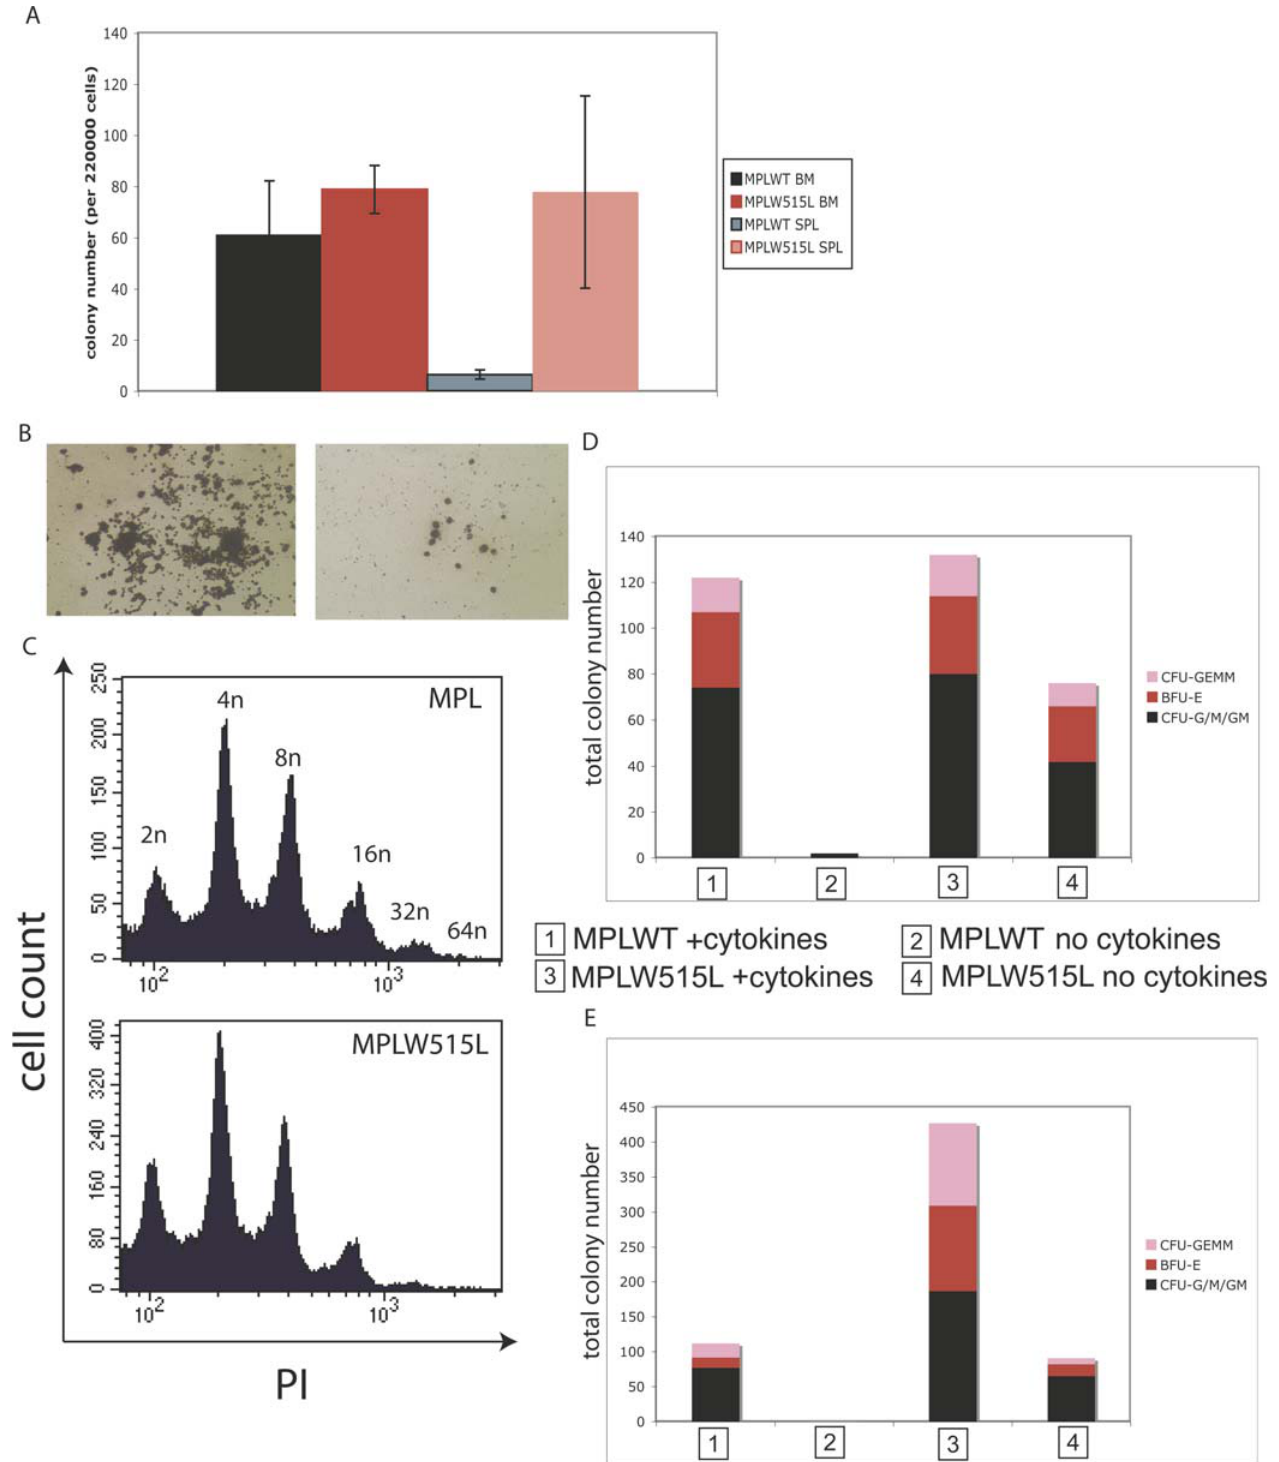
Figure 6. MPLW515L Increases the Number of Megakaryocyte and Myeloid Colonies in Spleen, without Affecting Megakaryocyte Ploidy, and Causes Cytokine-Independent Myeloid Colony Growth (A) Megakaryocyte colony–forming assay in the presence of TPO, IL3, IL11, and IL6 demonstrates similar numbers of megakaryocyte colonies obtained from MPLW515L-expressing bone marrow and an increase in the number of megakaryocyte colonies from spleen cells compared with MPLWT. (B) Acetylcholinesterase staining of megakaryocyte colonies derived from bone marrow demonstrates much larger colony size in MPLW515L as compared with MPLWT megakaryocyte colonies. (C) Megakaryocyte ploidy analysis shows the same distribution for MPLW515L-expressing cells and MPLWT-expressing cells. (D and E) Total myeloid colony formation from bone marrow cells (D) and spleen cells (E) demonstrates cytokine-independent colony formation in MPLW515L bone marrow and spleen. There is no difference in colony distribution between MPLWT- and MPLW515L-expressing cells. Colony counts reflect only positively identifiable colonies, with thorough megakaryocyte colony analysis done in MegaCult assay (Figure 6A), and thus are excluded from methylcellulose colony analysis. Colony numbers represent a total of three representative mice per group, in duplicate. DOI: 10.1371/journal.pmed.0030270.g006 PLoS Medicine |